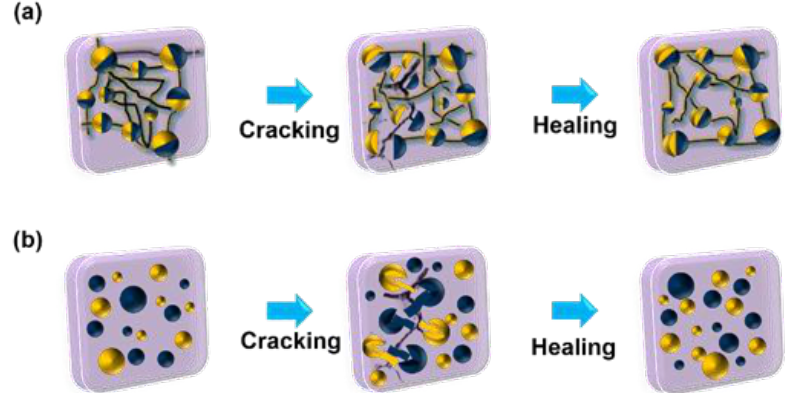
Figure 1. Schematic illustration of intrinsically self-healing polymer systems with ( a ): reversible chemical bonds and ( b ): self-healing through exhaustion of healing agents [16]. Reprinted with permission from Ref. [16]. Copyright 2017 John Wiley and Sons.